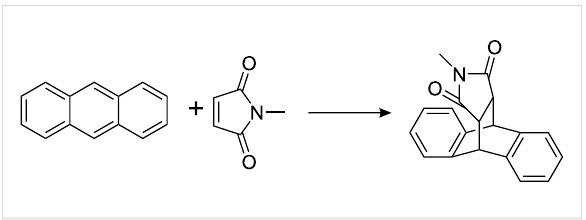
The intermolecular interaction of the guanidinium ion binding site of compound 2 with phosphate ester anions and dianions